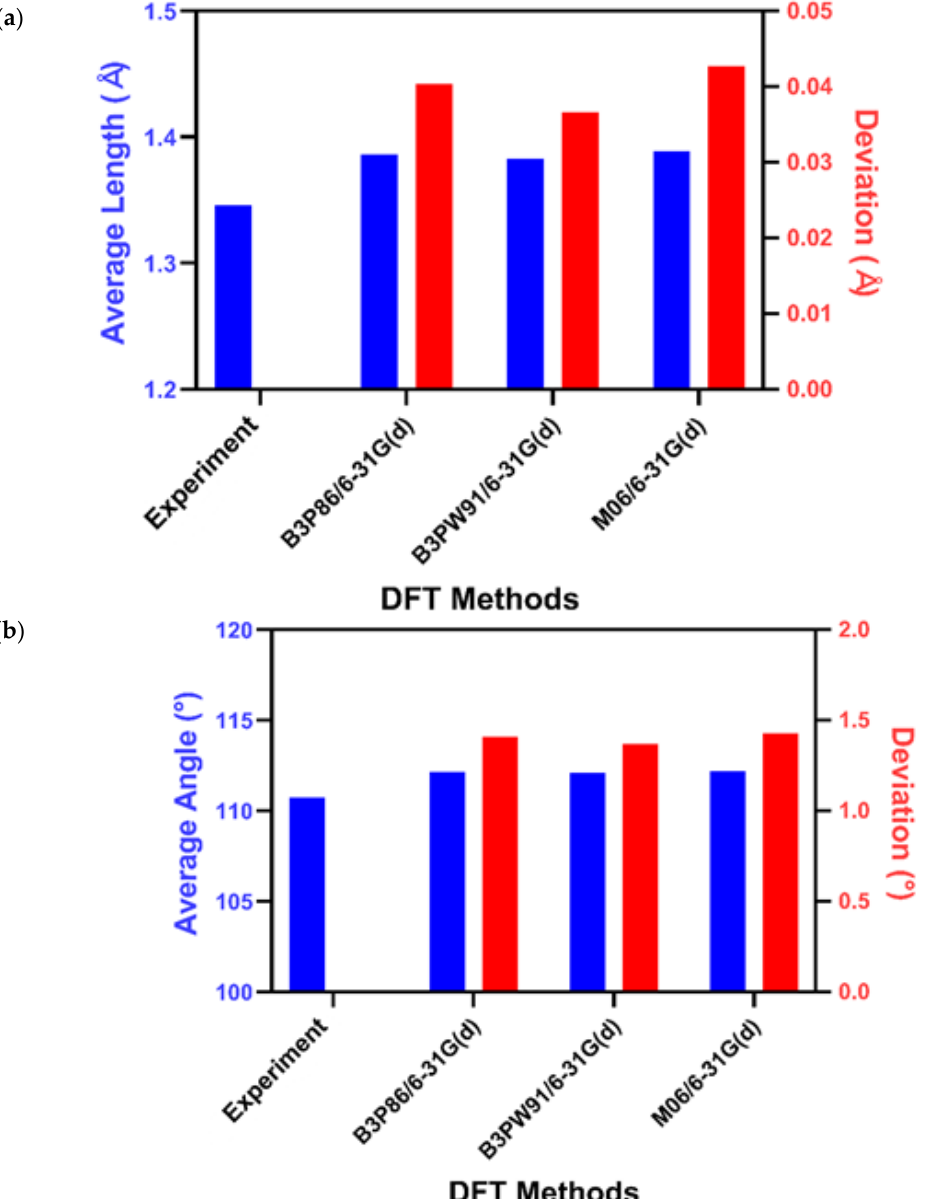
Figure 4. ( a ) Average bond length and ( b ) average angle of UO 2 (L)(MeOH) in the optimized struc- ture [17].